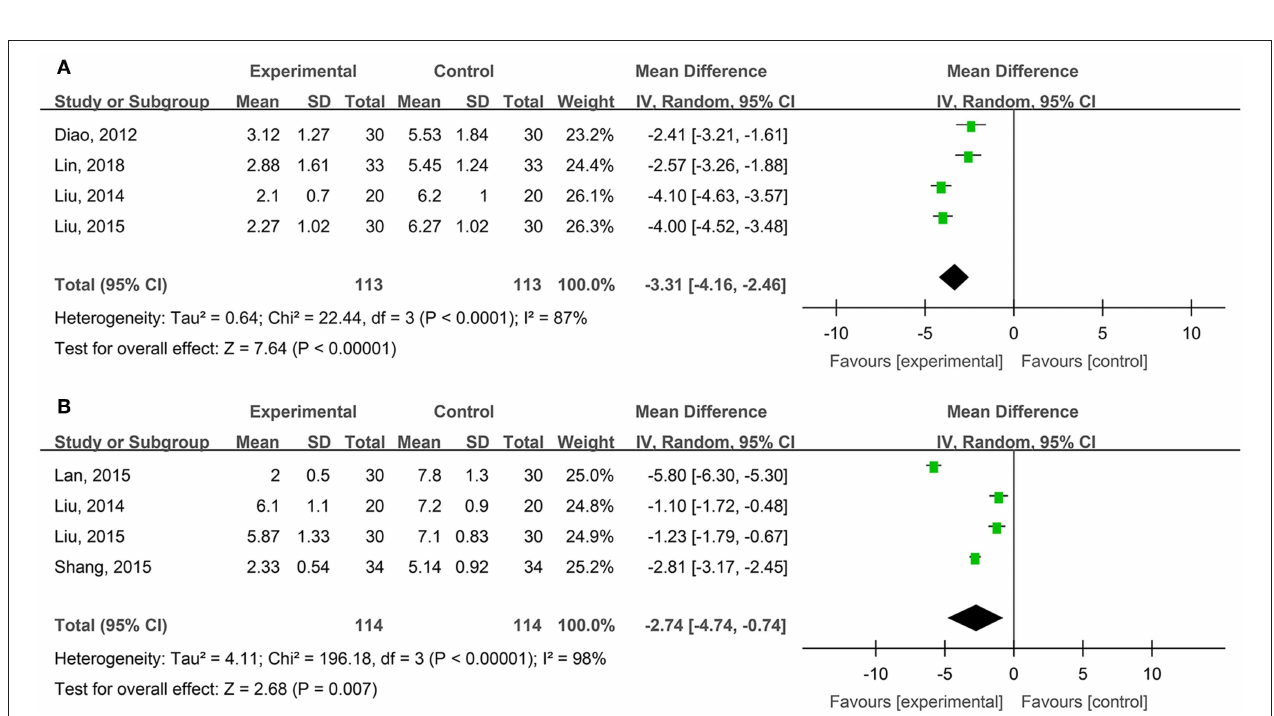
FIGURE 3 | Comparative meta-analysis of WHO pain ratings of burn wounds.